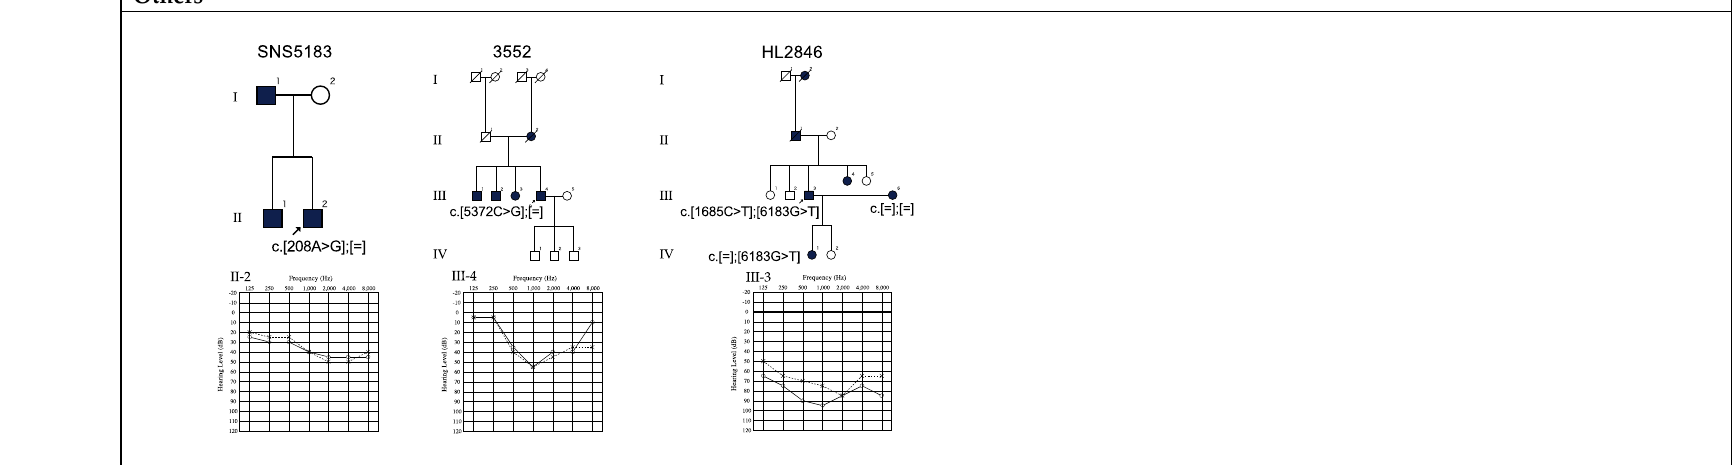
Figure 1. Pedigree and audiograms for each family with TECTA variants listed in Table 1. Arrows indicate the probands in each family. Genetic findings for each individual tested are noted in the pedigree. NIDO: nidogen-like domain, ZA: zonahesin-like domain, ZP: zona pellucida domain. Circle and solid line: right ear hearing threshold, X-mark and dotted line: left ear hearing threshold.